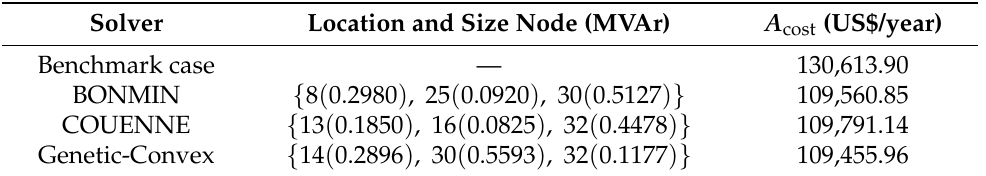
Table 6. Numerical results obtained after implementing mixed-integer nonlinear programming (MINLP) model in